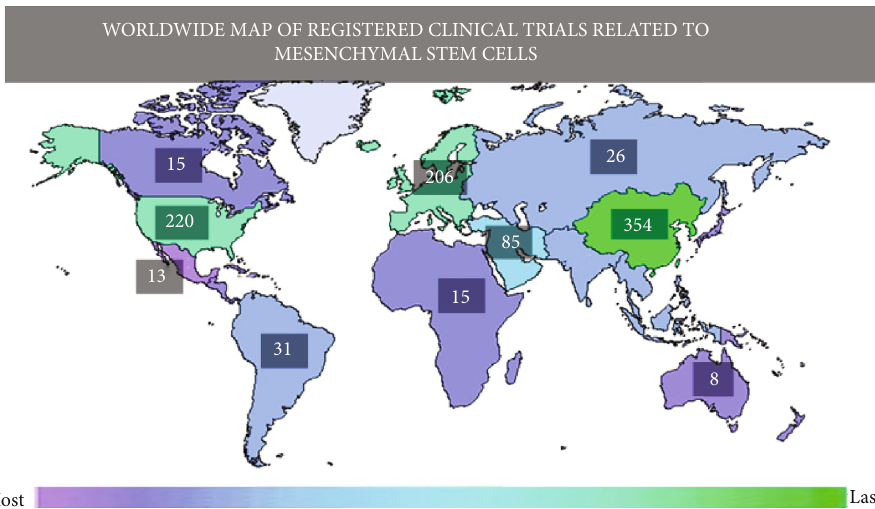
Figure 5: Worldwide map of registered clinical trials employing mesenchymal stem cells. The color indicates the number of studies within a region; exact study numbers are enclosed into labels. The number of studies by region: Africa 15, Central America 10, East Asia 354, Japan 9, Europe 206, Middle East 85, North America 230, Canada 15, Mexico 3, United States 220, North Asia 26, Paci fi ca 8, South America 31, South Asia 29, and Southeast Asia 29. Extracted and modi fi ed from